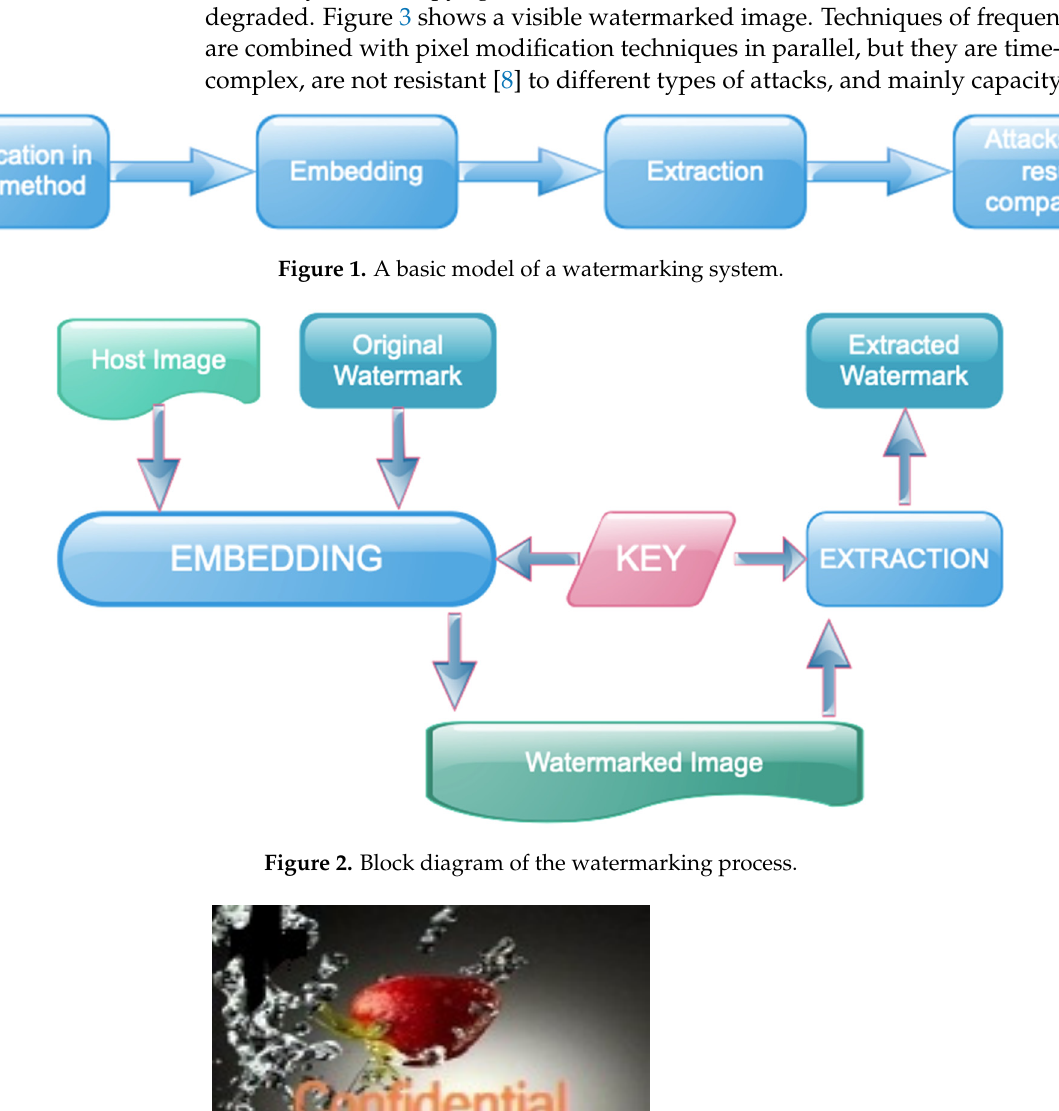
Figure 2. Block diagram of the watermarking process.